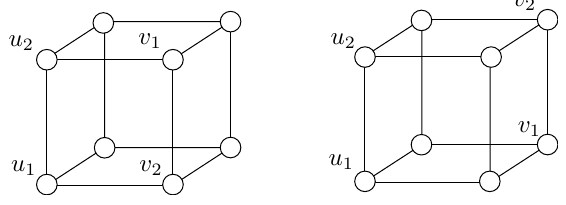
Fig. 2: The only non-connectable balanced families of two pairs of vertices of Q